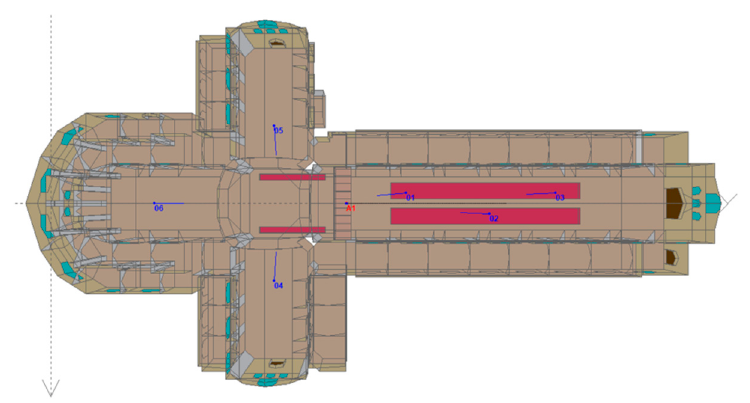
Figure 5. Sound source and receivers from the pulpit to the nave section.